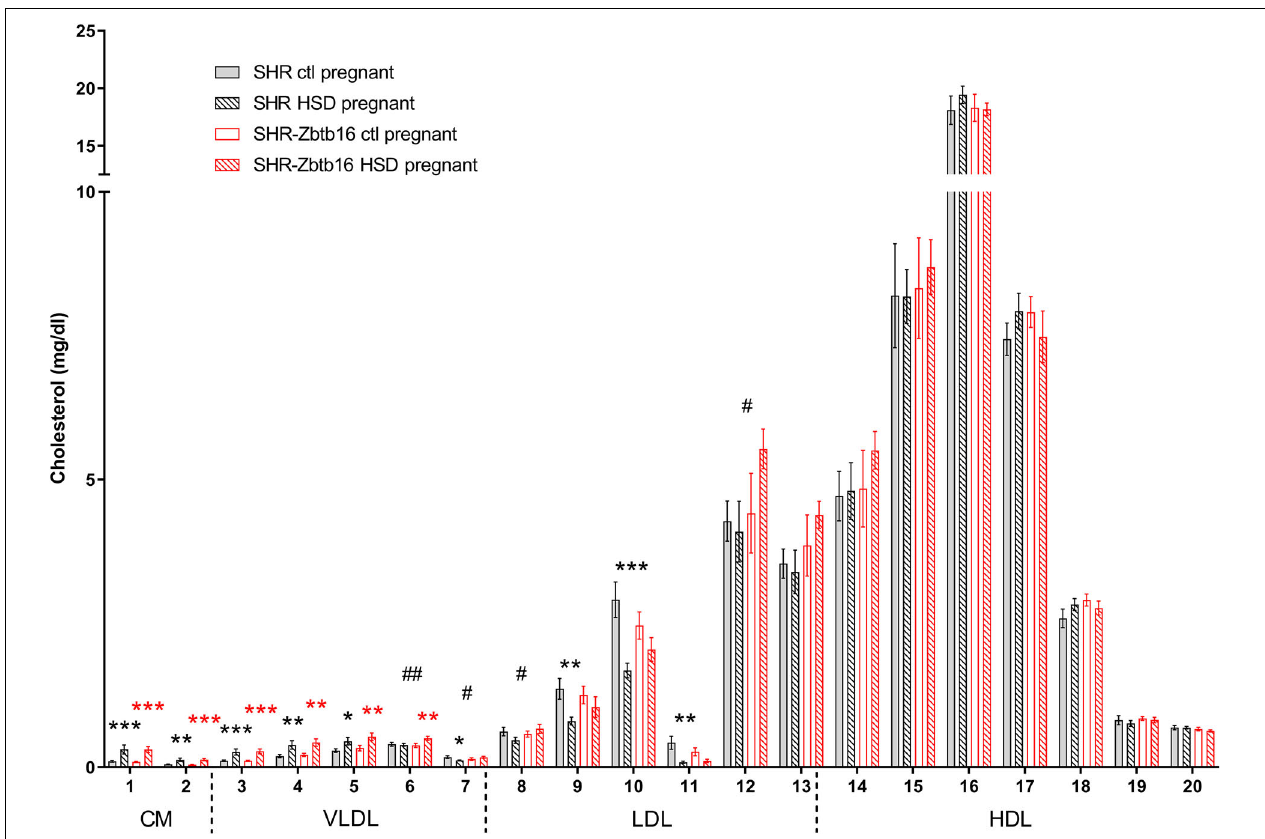
FIGURE 5 | Cholesterol profile. The cholesterol (C) content in 20 lipoprotein subfractions in pregnant SHR female rats and SHR- Zbtb16 female rats – SHR fed standard diet in pregnancy (SHR ctl pregnant – light gray bars), SHR fed HSD in pregnancy (SHR HSD pregnant – black patterned bars), SHR- Zbtb16 fed standard diet in pregnancy (SHR- Zbtb16 ctl pregnant – open red bars) and SHR- Zbtb16 fed HSD in pregnancy (SHR- Zbtb16 HSD pregnant – patterned red bars). Cholesterol profile before pregnancy is shown in Supplementary Material . Within the graph and this legend, the significance levels of pair-wise comparisons (ctl pregnant vs. HSD pregnant) by post-hoc Fisher’s test of the two-way ANOVA with STRAIN and DIET as major factors are indicated as follows: * p < 0.05, ** p < 0.01, *** p < 0.001. Black asterisks mark significance levels between SHR ctl pregnant and SHR HSD pregnant, red asterisks mark significance levels between SHR- Zbtb16 ctl pregnant and SHR- Zbtb16 HSD pregnant. # represents differences in specific lipoprotein fractions between SHR HSD pregnant and SHR- Zbtb16 HSD pregnant; # p < 0.05, ## p < 0.01. C6 ## , C7 # , C8 # , C12 # , which were all higher in SHR- Zbtb16 . The allocation of individual lipoprotein subfractions to major lipoprotein classes is shown in order of particle’s decreasing size from left to right. CM, chylomicron; VLDL, very low density lipoprotein; LDL, low density lipoprotein; HDL, high density